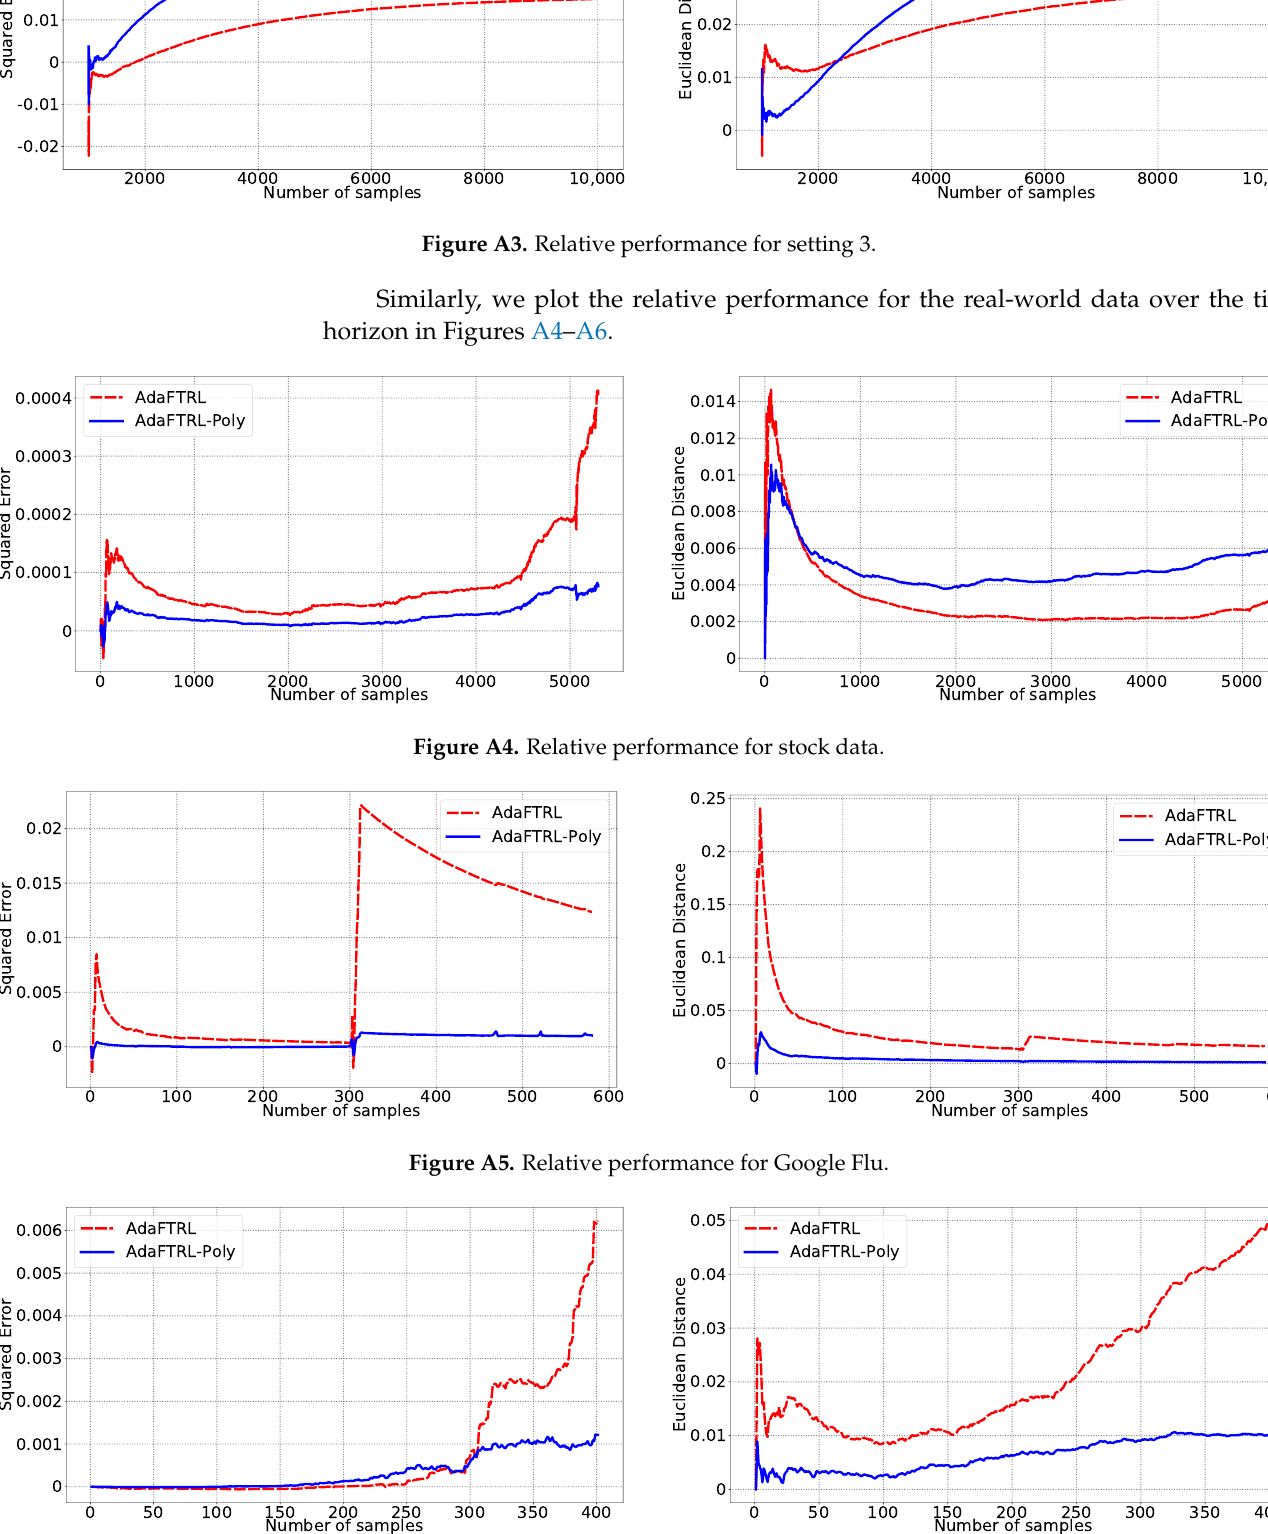
Figure A6. Relative Performance for electricity